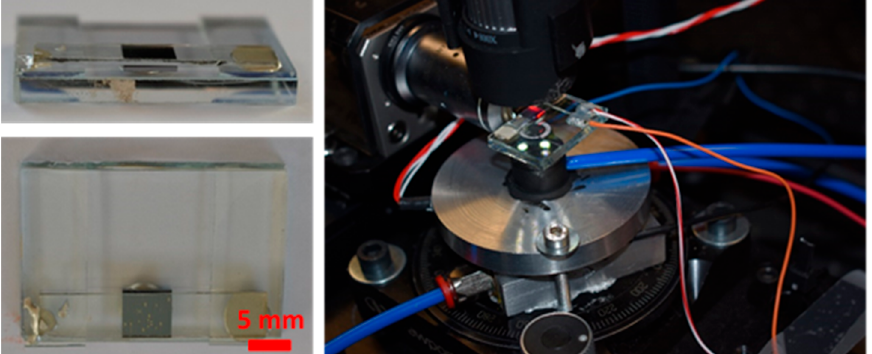
Figure 3. The mounted liquid crystal covered photonic chip. A HeNe laser was coupled to the MZI using a high-power microscope objective. The output was monitored using a Nikon D500 CMOS camera (Nikon Corporation, Shinagawa, Tokyo, Japan) with a macro lens.